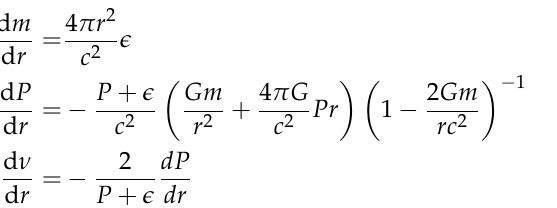
Table 1. Frequencies of the fundamental ( ω 0 ) radial oscillation mode and the first overtone ( ω 1 ) in the vector interaction enhanced Bag model (vBag) model of strange stars. All configurations are stable against oscillations, i.e., have ω 2 > 0. M ∗ ( km ) = 1.477 M ( M (cid:12) ) and ω ∗ ( km − 1 ) = 0.0209 ω ( kHz ) . EOS Mass Radius Compactness R / M ∗ Frequency [kHz] Frequency [ ω ∗ √ B , B eff [MeV/fm 3 ] K v [GeV − 2 ] ρ c [ 10 − 3 km − 2 ]